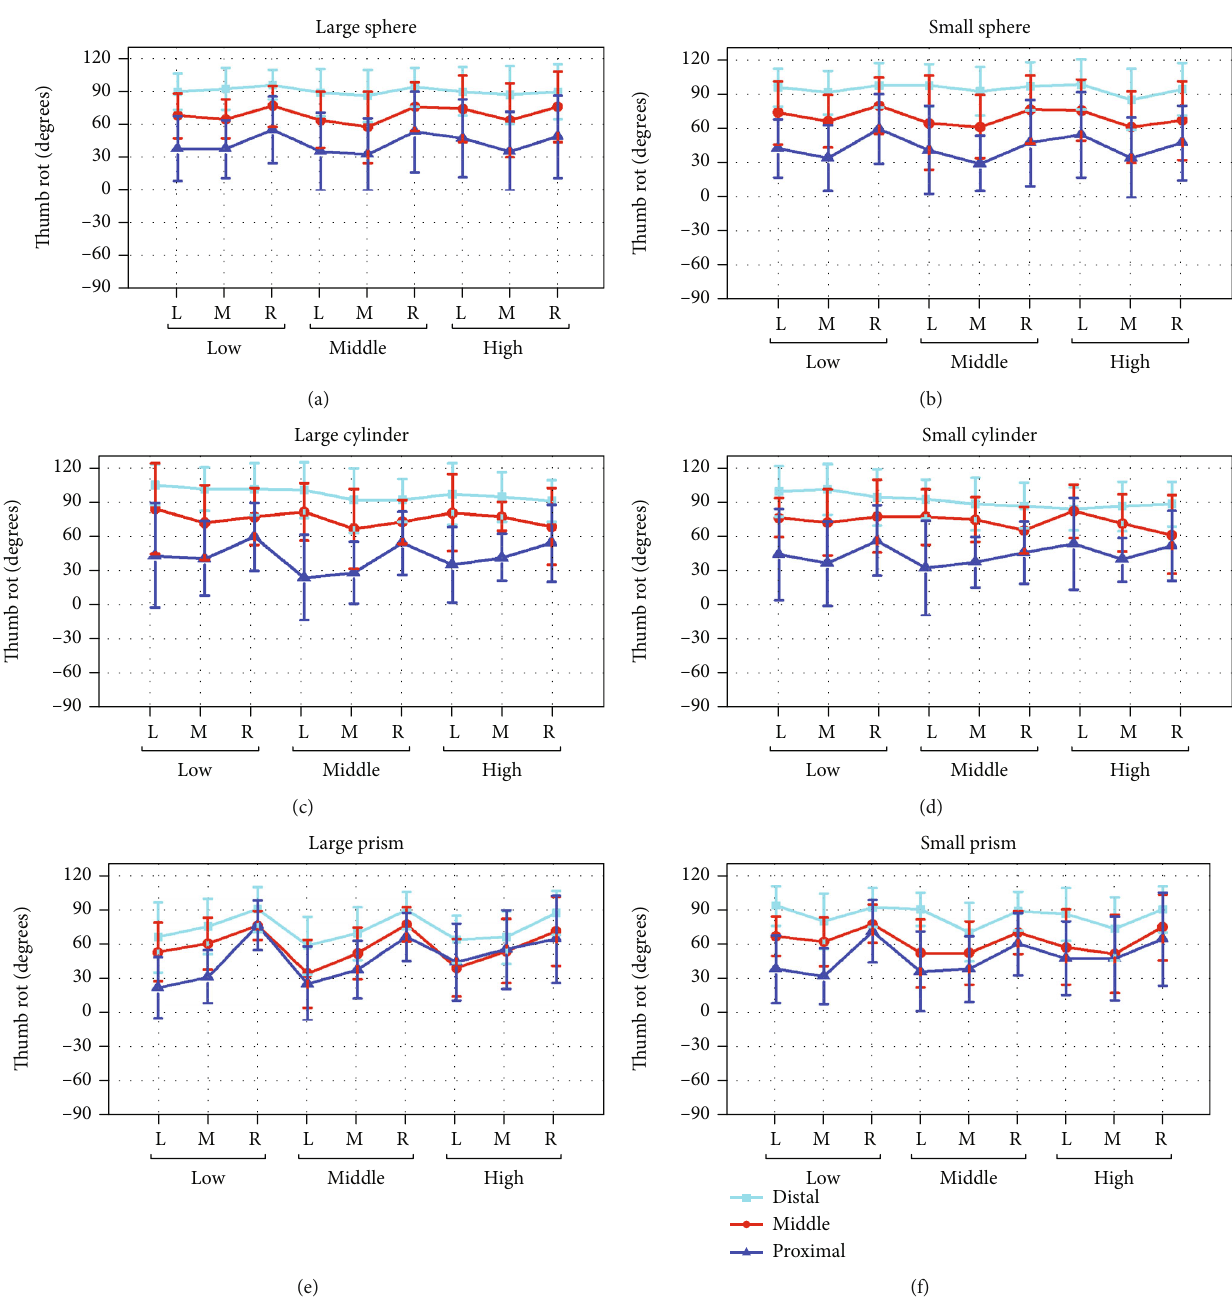
Figure 4: Thumb rotation joint angle in fl uenced by the object shape, object size, X deviation, Y deviation, and Z deviation. L, M, and R represent the X deviation from left to right. Low, middle, and high represent the Z deviation from low to high. Distal, middle, and proximal represent the Y deviation from distal to